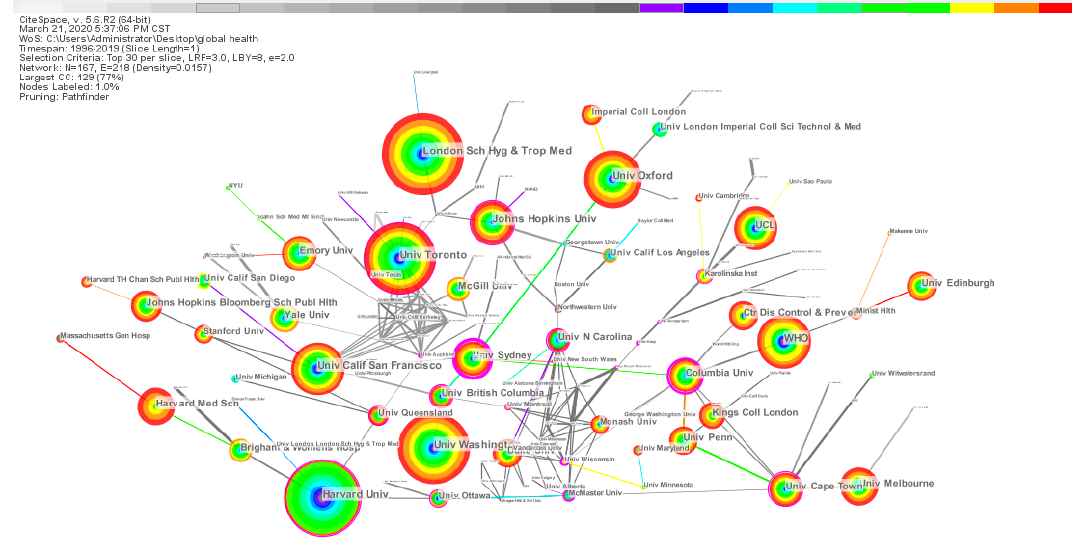
Figure 5. Knowledge map of co-institution collaboration network.